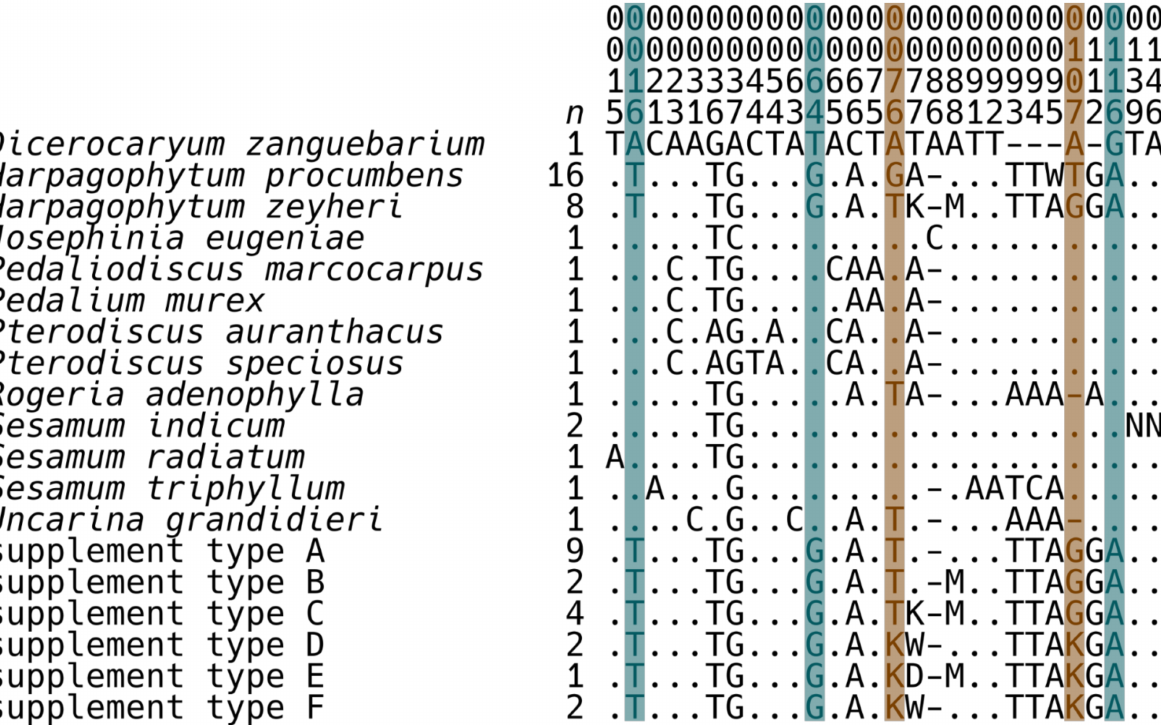
Figure 1. Variable nucleotides within the psbA-trnH mini-barcode (voucher information is in Table 1; herbal dietary supplement information is in Table 2; the full alignment is in Figure A1). Alignment positions are numbered vertically. Bases identical to the first sequence are indicated with “.”. Variable bases are indicated with standard International Union of Pure and Applied Chemistry (IUPAC) codes: D = {AGT}, K = {GT}, M = {AC}, N = {ACGT}, and W = {AT}. The number of sequences summarized ( n ) for each species/supplement type is indicated. Alignment positions that unambiguously distinguish Harpagophytum from all other Pedaliaceae (16, 64, and 116) are highlighted in blue. The alignment positions 76 and 107—which distinguish between the two Harpagophytum species—are highlighted in